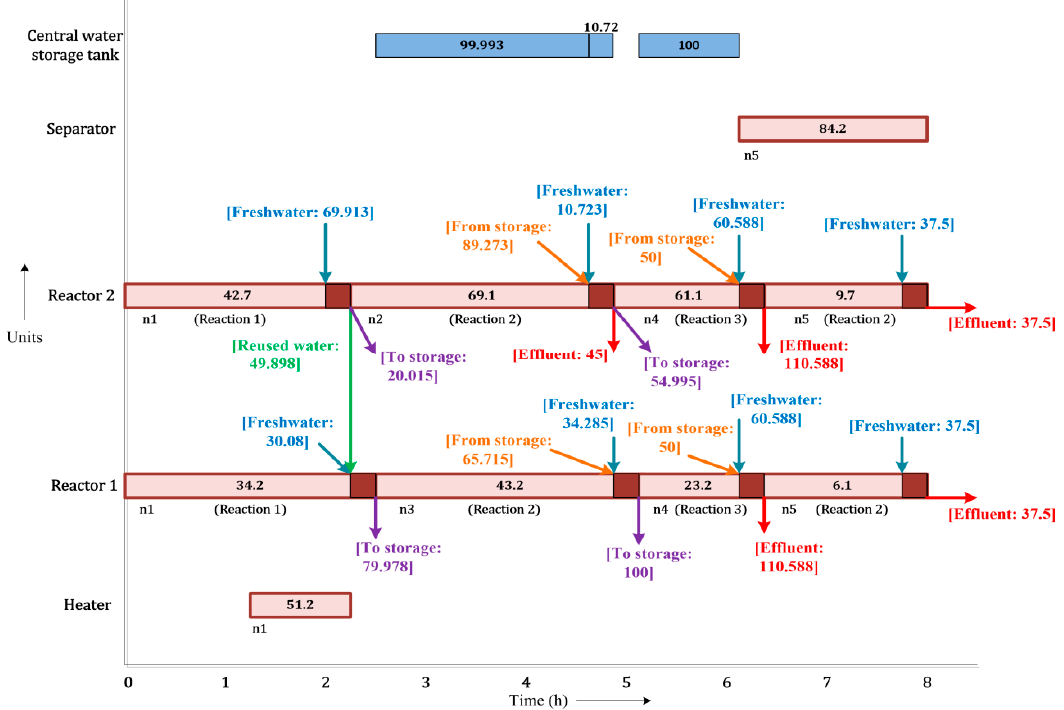
Figure 6. Gantt chart for the sequential approach without using water storage tank for case study 1.